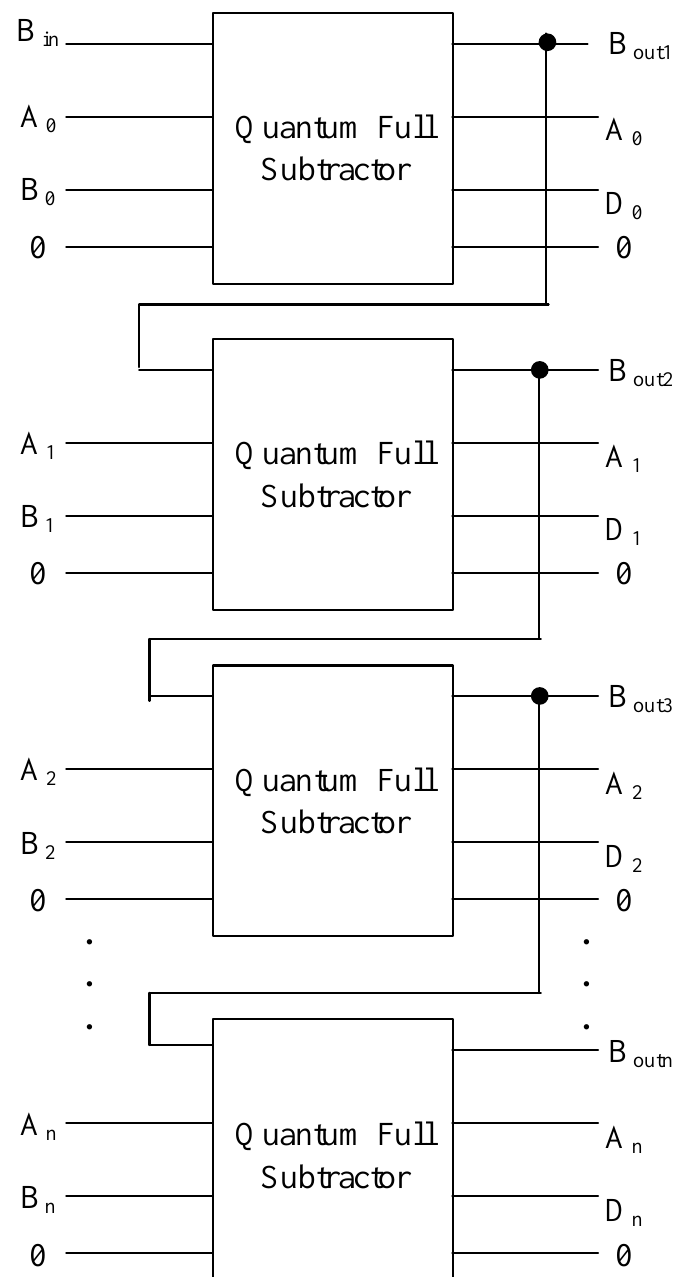
Figure 15. Multi-qubit string comparator using Gidney’s